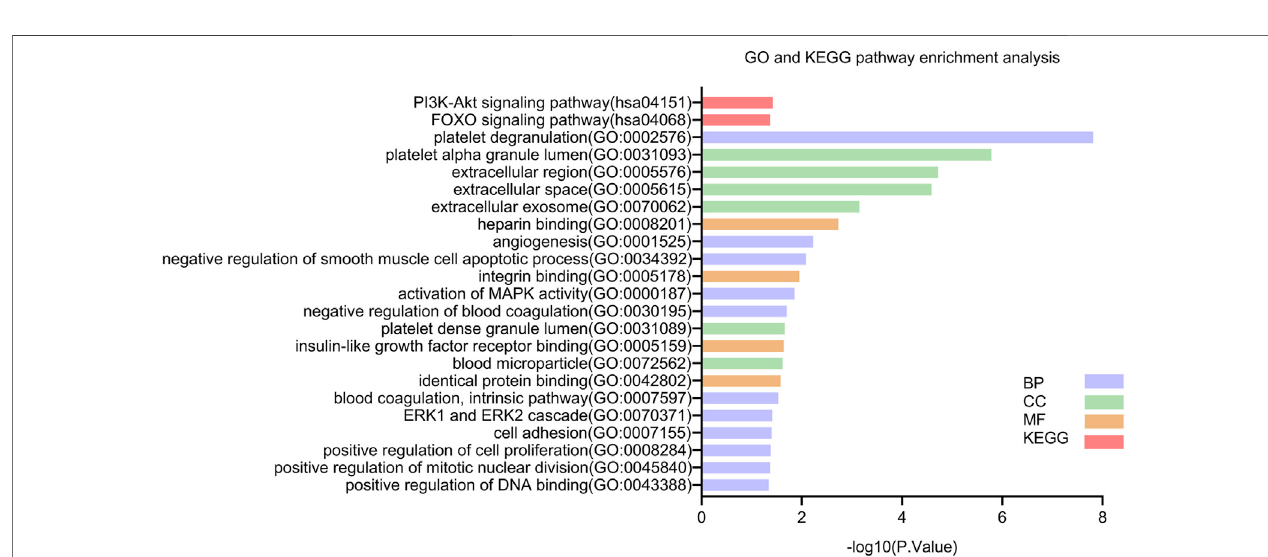
FIGURE 2 | Venn diagram of DEGs common to two GEO datasets. A total of 45 consistently expressed genes were identi fi ed from GSE121233 and GSE129973, including 18 upregulated genes (A) and 27 downregulated genes (B) in FSGS kidney tissues compared to the control. Different color areas represented different datasets. The cross areas indicate the common expressed genes. Abbreviations: DEGs, differential expression genes; GEO, Gene Expression